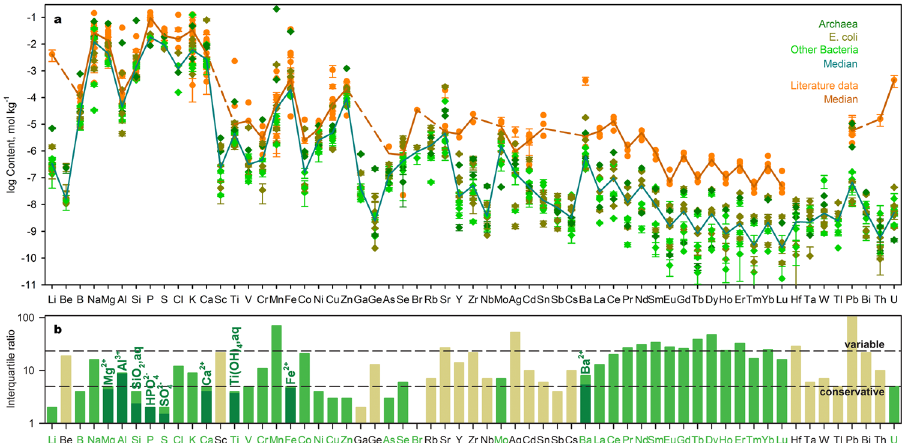
Figure 1. Composition of prokaryotes and dispersion of elemental abundances. ( a ) Observed prokaryotic compositions versus literature data. Uncertainties (1 σ ) comprise reported values for literature data and variations in our repeated measurements. ( b ) Interquartile ratios calculated for measured elemental contents in prokaryotes (n = 11, see Methods). Biologically essential chemical elements (Supplementary Discussion) are marked by green color. Also the plot illustrates the dispersion of solution species (dark green) supporting the mineral fingerprints considered in this